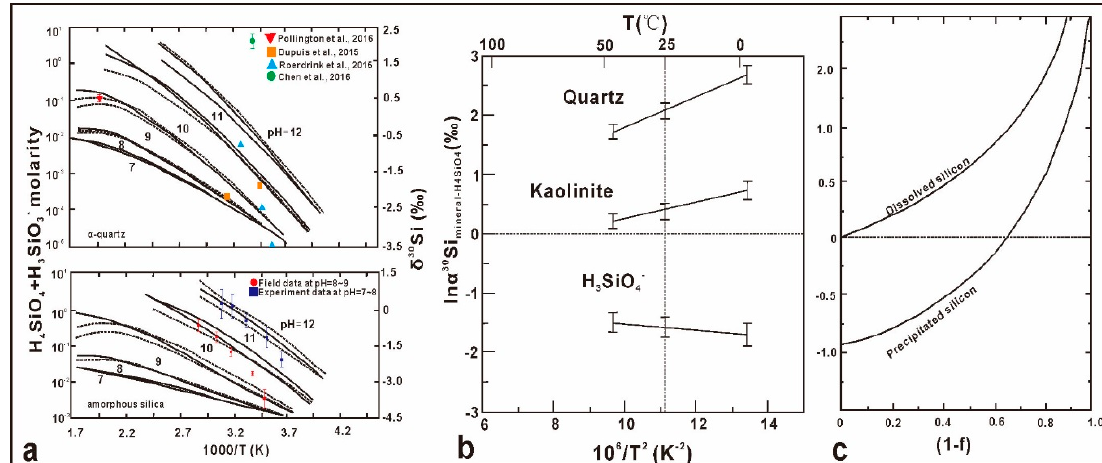
Figure 4. ( a ) Solubility of α -quartz and amorphous silica as a function of temperature at various pH. Dotted line: γ = 1.0. Dashed line: γ in Fleming et al. 1982 (data compiled from References [29,37,87,92,103,106,107]); ( b ) calculated equilibrium fractionation factors of silicon factors between minerals (quartz and kaolinite) and dissolved silicon speciation of H 4 SiO 40 , and between H 4 SiO 40 and H 3 SiO 4 − (modified with permission from Dupuis et al., Chem. Geol. published by Elsevier, 2015); ( c ) kinetic fractionation of silicon isotopes in silica precipitation process from solution at pH 7 in room temperature with the α precipitated-dissolved factor of 0.9990 given by Li et al. [102]).